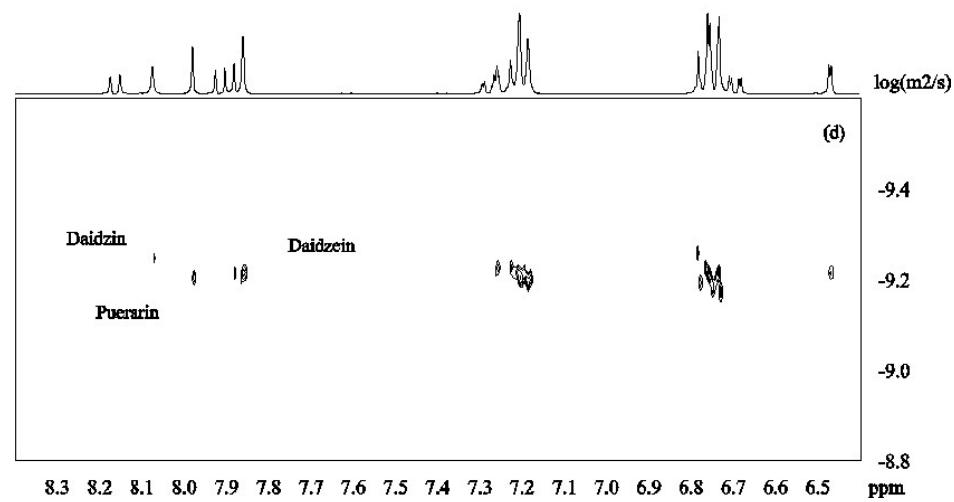
Figure 4. DOSY spectra of daidzein, daidzin and puerarin (( a ): 2.0 mM for each); in the presence of β -CD (( b ): β -CD 2.0 mM; ( c ): β -CD 4.0mM; ( d ): β -CD 6.0 mM in D 2 O, 30 °C).